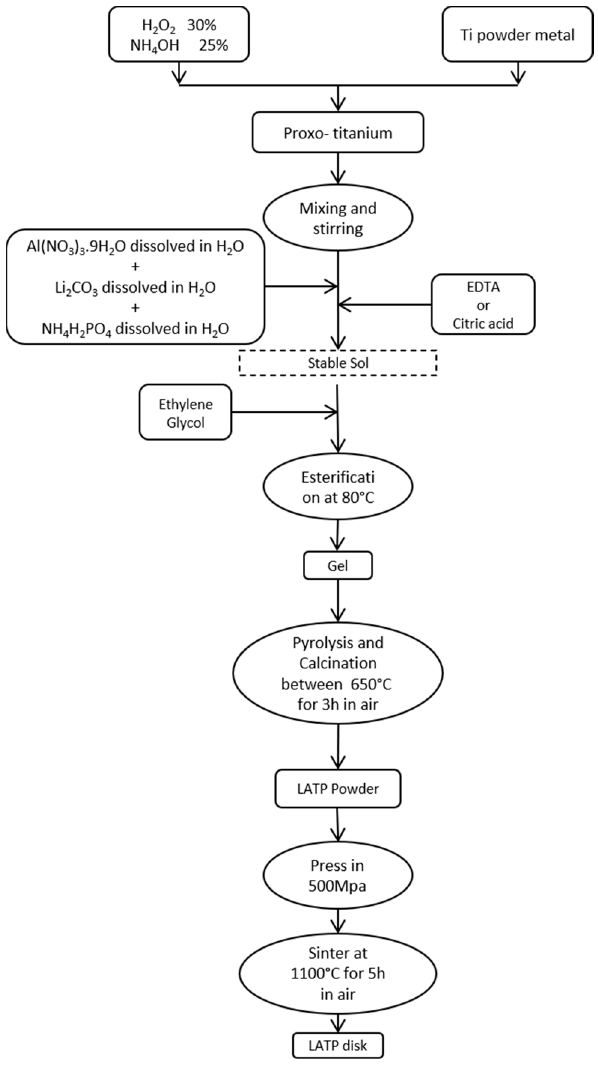
Figure 1. The flowchart of the synthesis process of LATP disk.